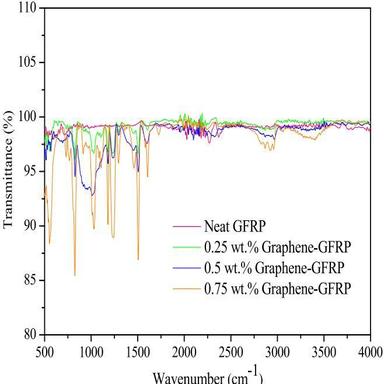
FTIR spectra for GFRP composites with various wt% of graphene. Fig. 3. XRD spectra for GFRP composites with various wt% of graphene.